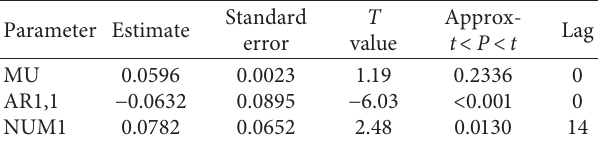
Table 4: RDL model estimation